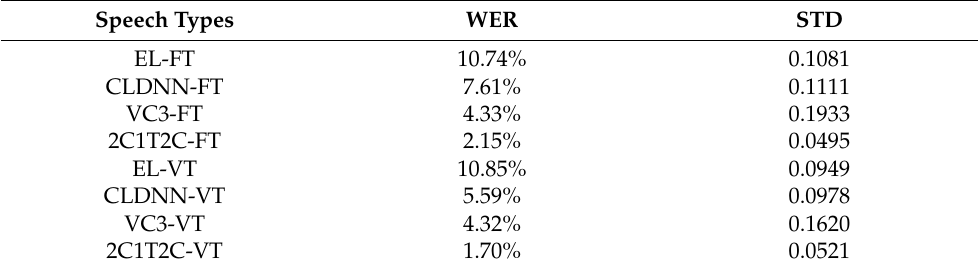
Table 7. The statistical WER of unenhanced/enhanced continuous Mandarin EL